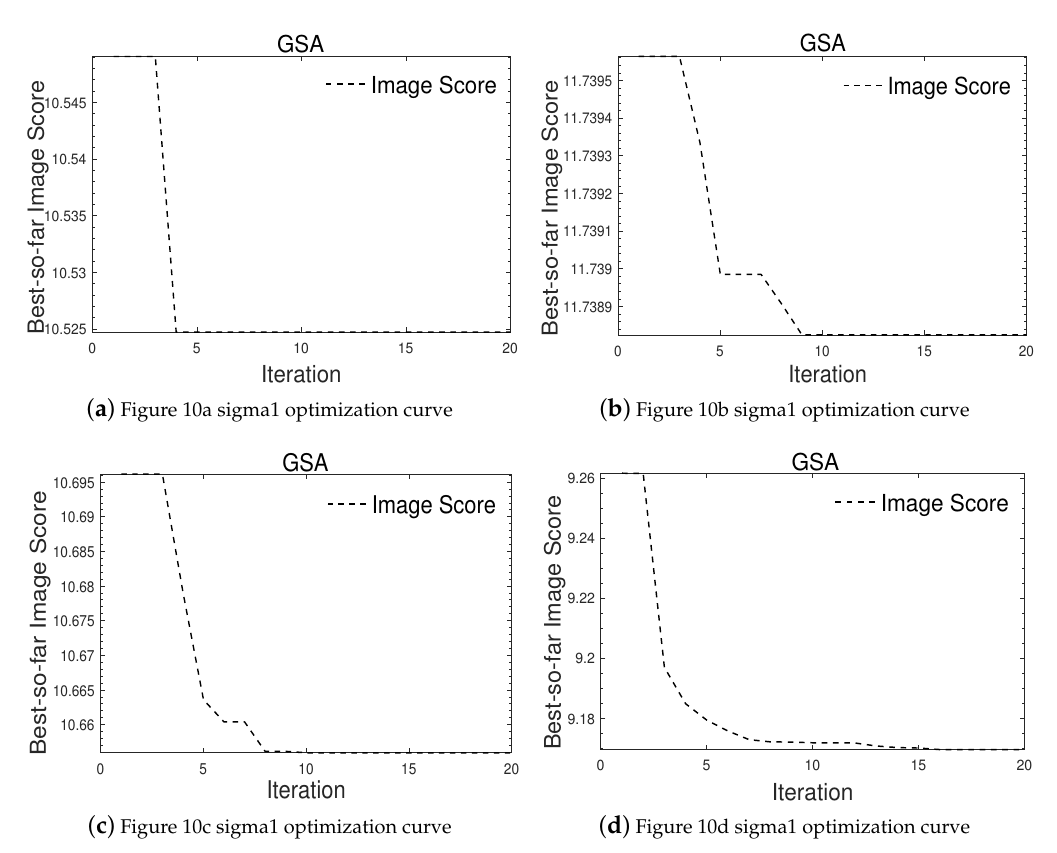
( c ) Figure 10c sigma1 optimization curve ( d ) Figure 10d sigma1 optimization curve Figure 11. Sigma1 optimization fitness evolution